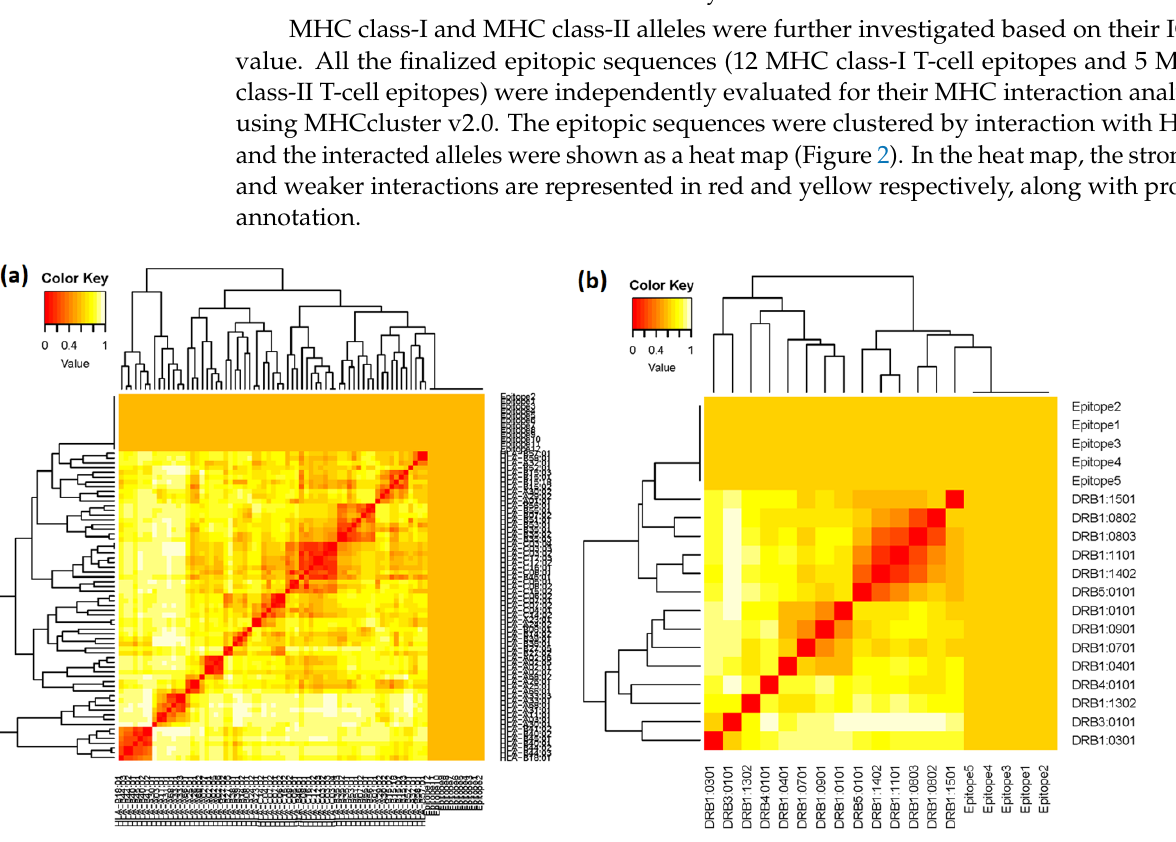
Figure 2. MHC clustering based on binding specificity: ( a ) heat map of 12 MHC class-I T-cell epitopes, and ( b ) heat map of 5 MHC class-II T-cell epitopes.